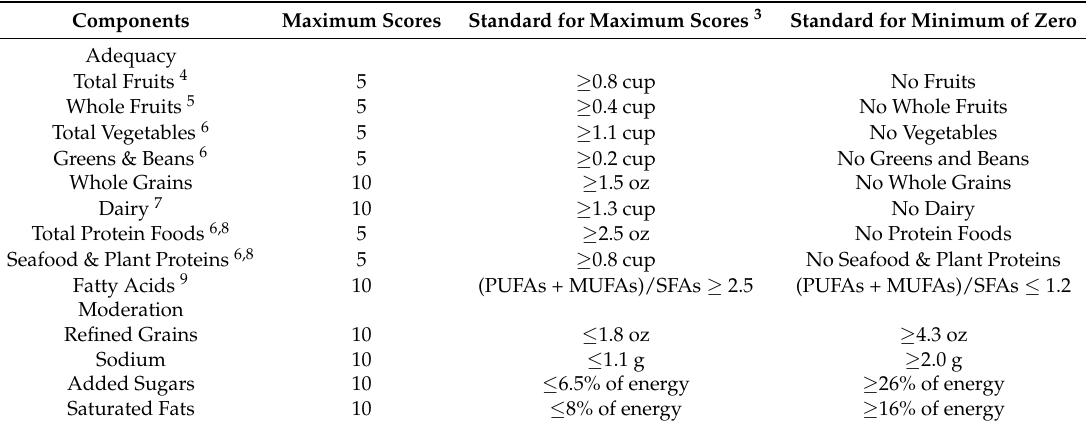
Table 1. Healthy Eating Index-2015 (HEI-2015) component scoring standards using standardized cup and ounce equivalents from the MPED 1,2,3